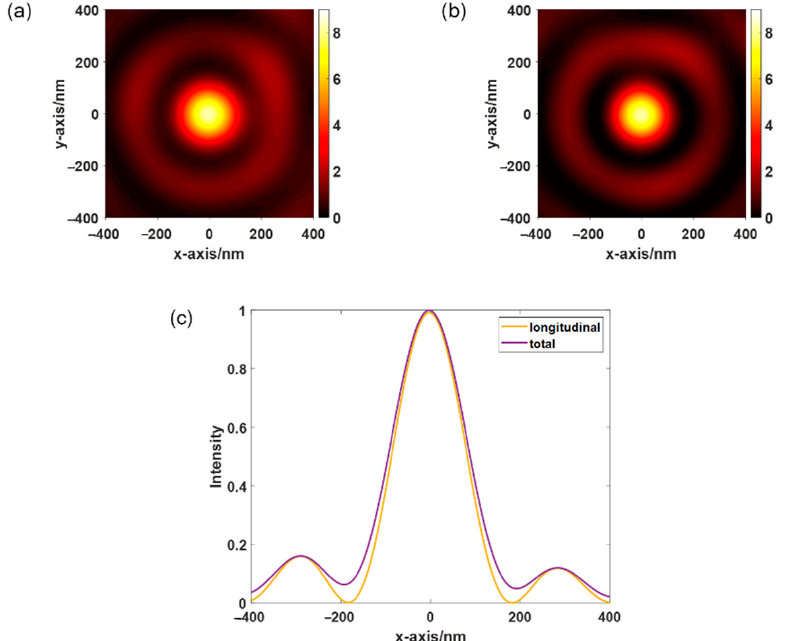
Figure 4. Distribution of ( a ) total electric field strength, ( b ) longitudinal electric field strength, and ( c ) normalized total electric field strength and longitudinal electric field strength along y=0.